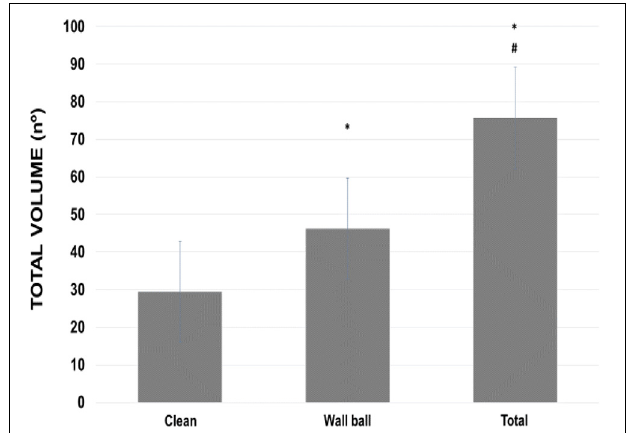
FIGURE 5 | Total volume (series × repetitions) used during WOD-AMRAP (workout of the day, method as many reps as possible) for clean and wall ball exercises, and the total load of the training session. ∗ p < 0.01 vs clean exercise; # p < 0.01 vs clean and wall ball exercises. ANOVA ( F ) = 66.854, p < 0.01.